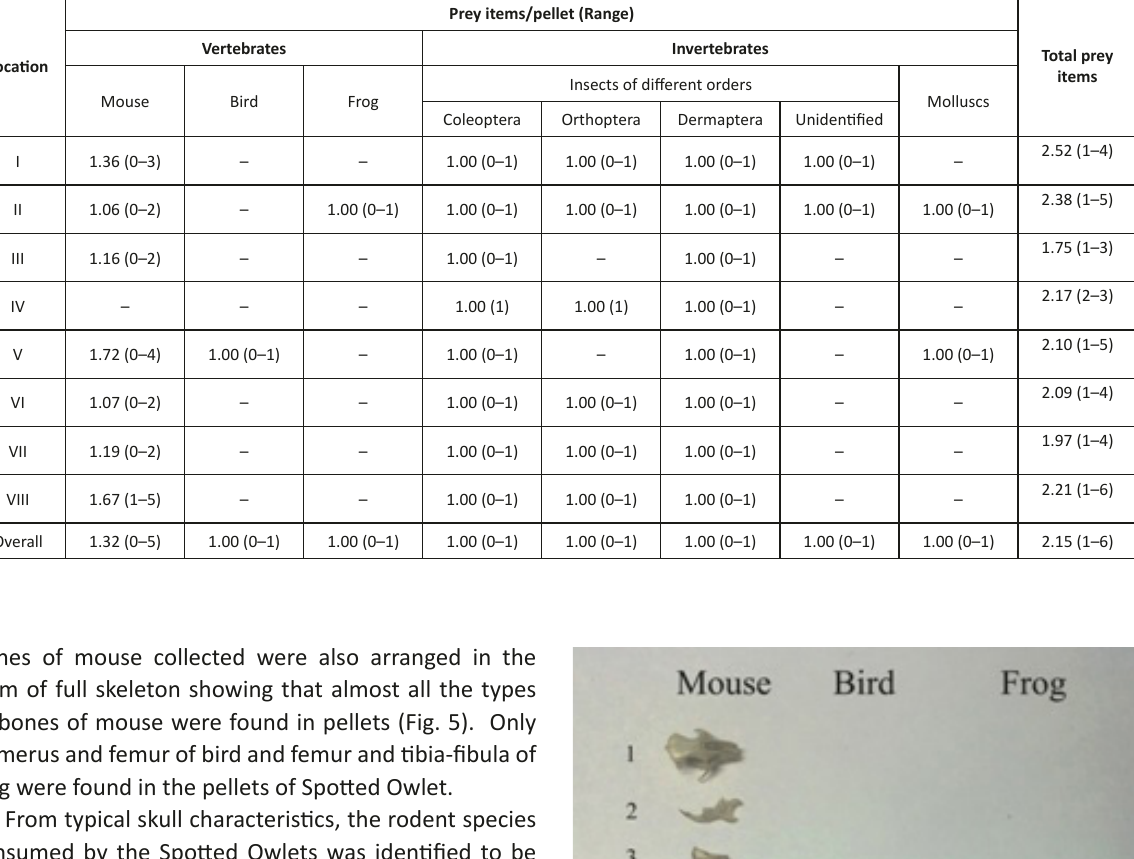
Table 2. Mean number of prey items per pellet of Spotted Owlet at all the eight locations.